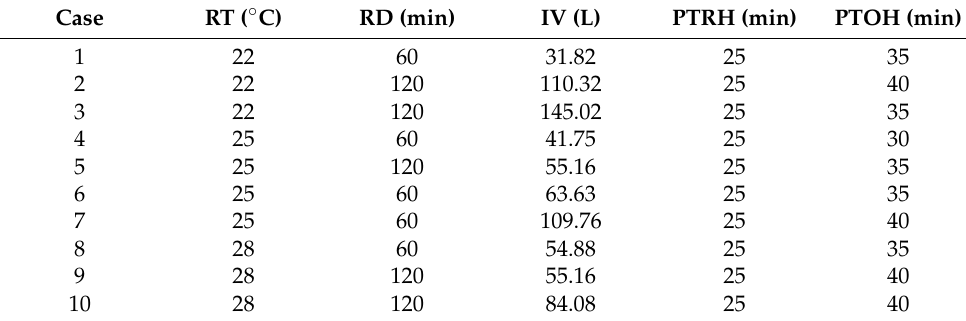
Table 5. The design of the experimental